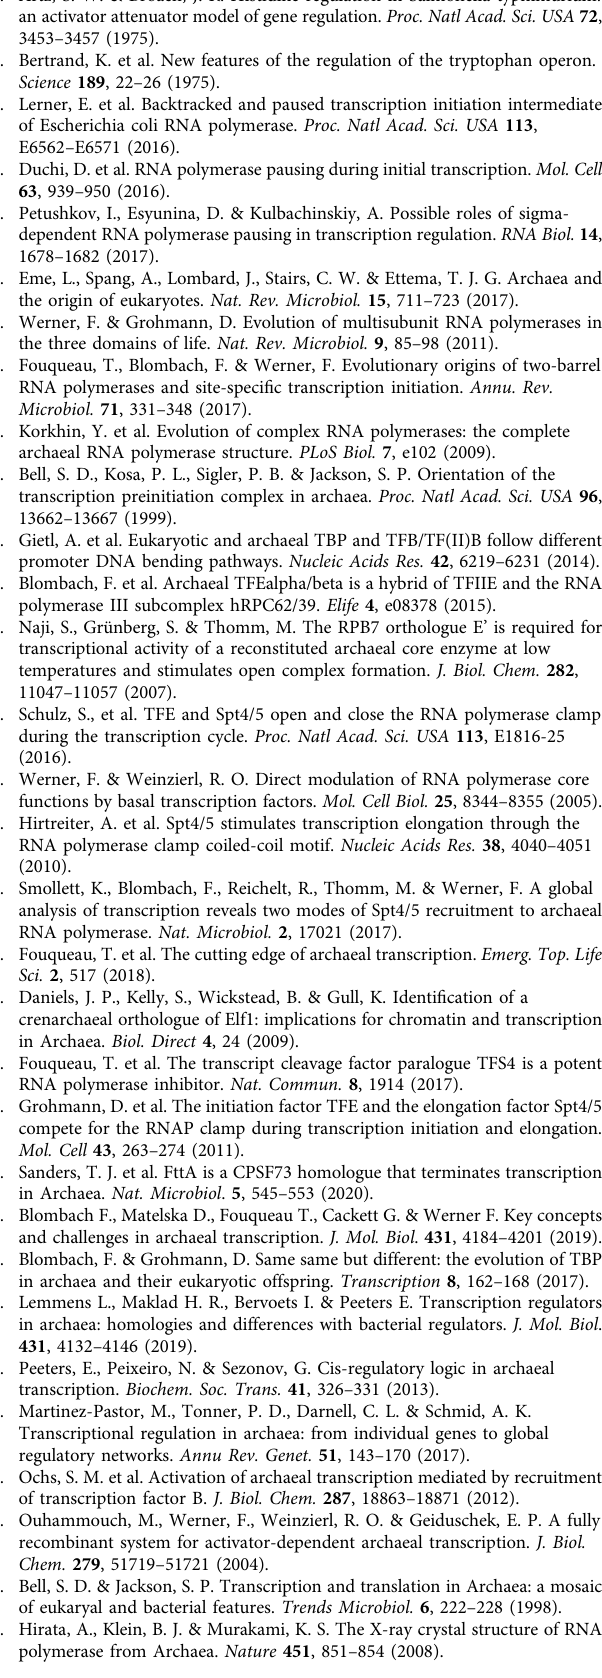
(Supplementary Table 1). 3 ′ -biotinylation of the oligonucleotides was carried out with biotin-14-dATP (Jena Bioscience) and Terminal transferase (New England Biolabs). Transcripts and biotinylated oligonucleotides were allowed to hybridise overnight at room temperature. Samples were mixed with 120 µl of